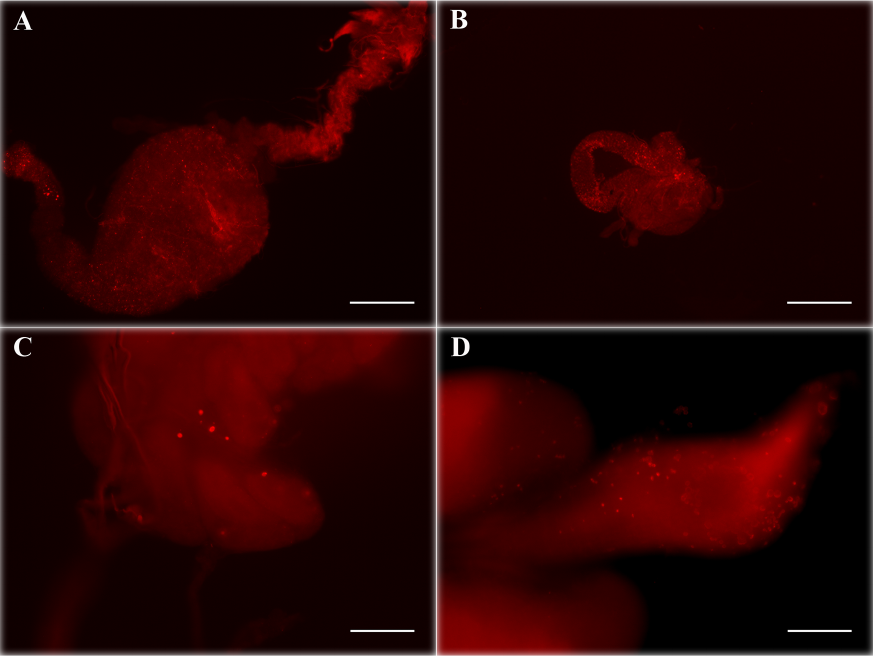
Figure 2. Invivo detection of Wa F17.12-KT by IFA assay using mAbKT4. Red stained yeasts are visible in the mosquito organs after feeding sugar solution supplemented with Wa F17.12 cells cultivated in Wa KT stimulating condition: Female (A) and male (B) guts analyzed on the 10 th